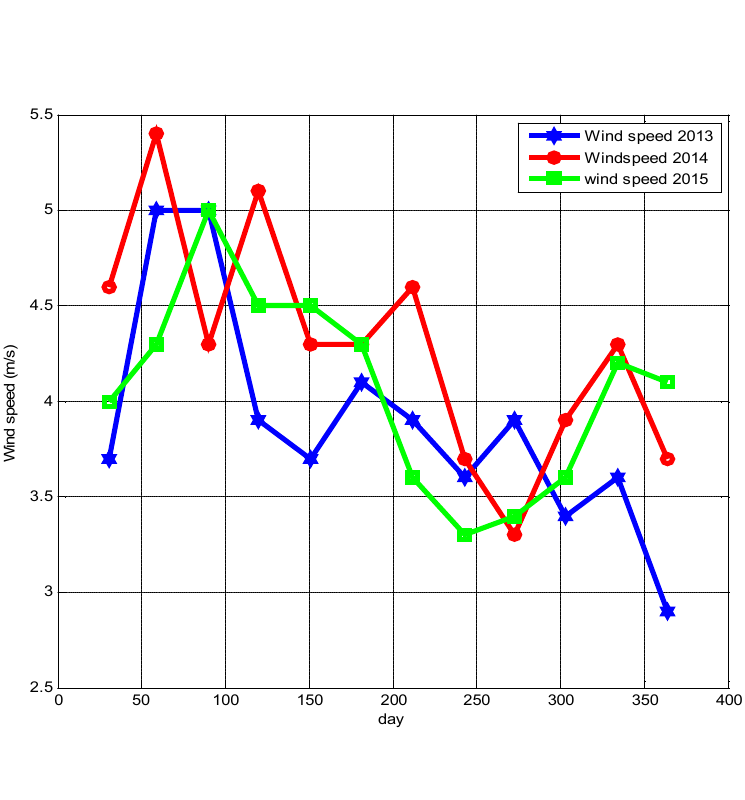
Figure 1 . Annual variation of the monthly average of wind speed in the zone of Thies for years 2013, 2014 and 2015.